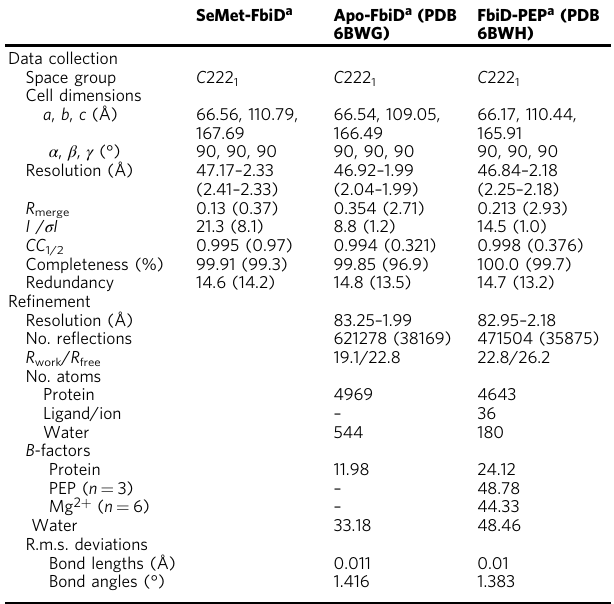
Table 1 Data collection, processing, and re fi nement